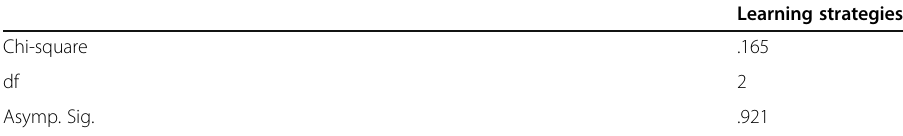
Learning strategies